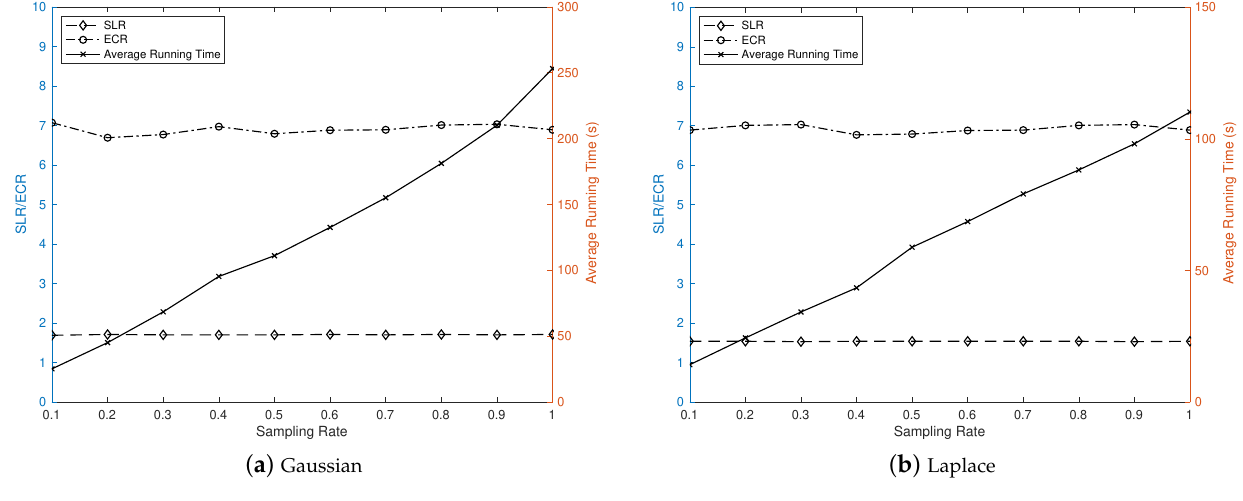
Figure 10. Impact of the sampling